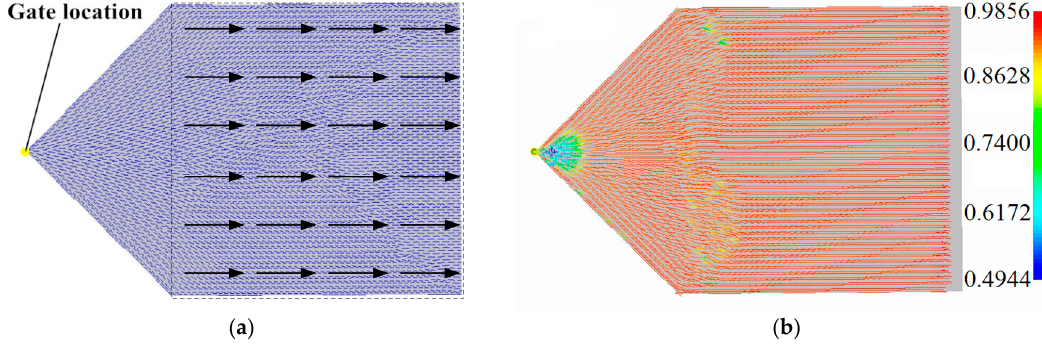
Figure 1. Fiber orientations of the transversely isotropic material plate (dashed region), ( a ) the fiber orientation and ( b ) the corresponding fiber orientation tensor (a11).